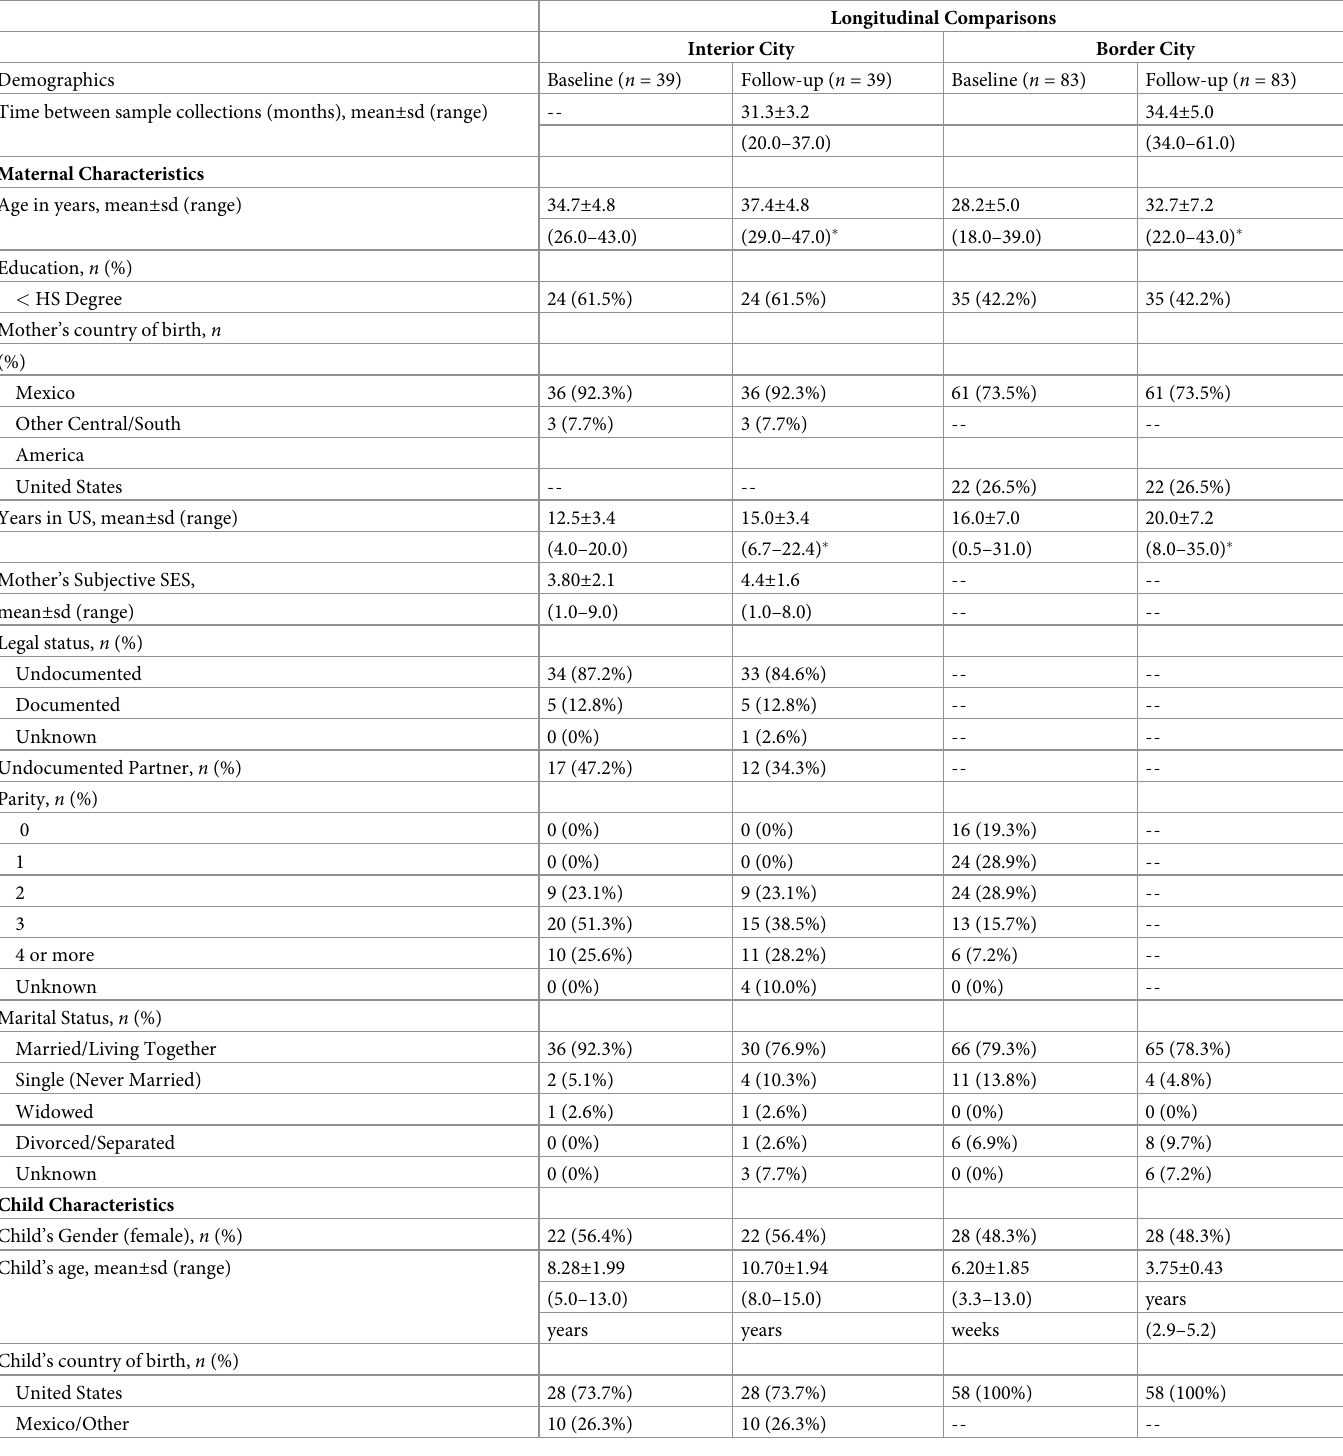
Table 1. Demographics of study samples at baseline and follow-up in interior and border